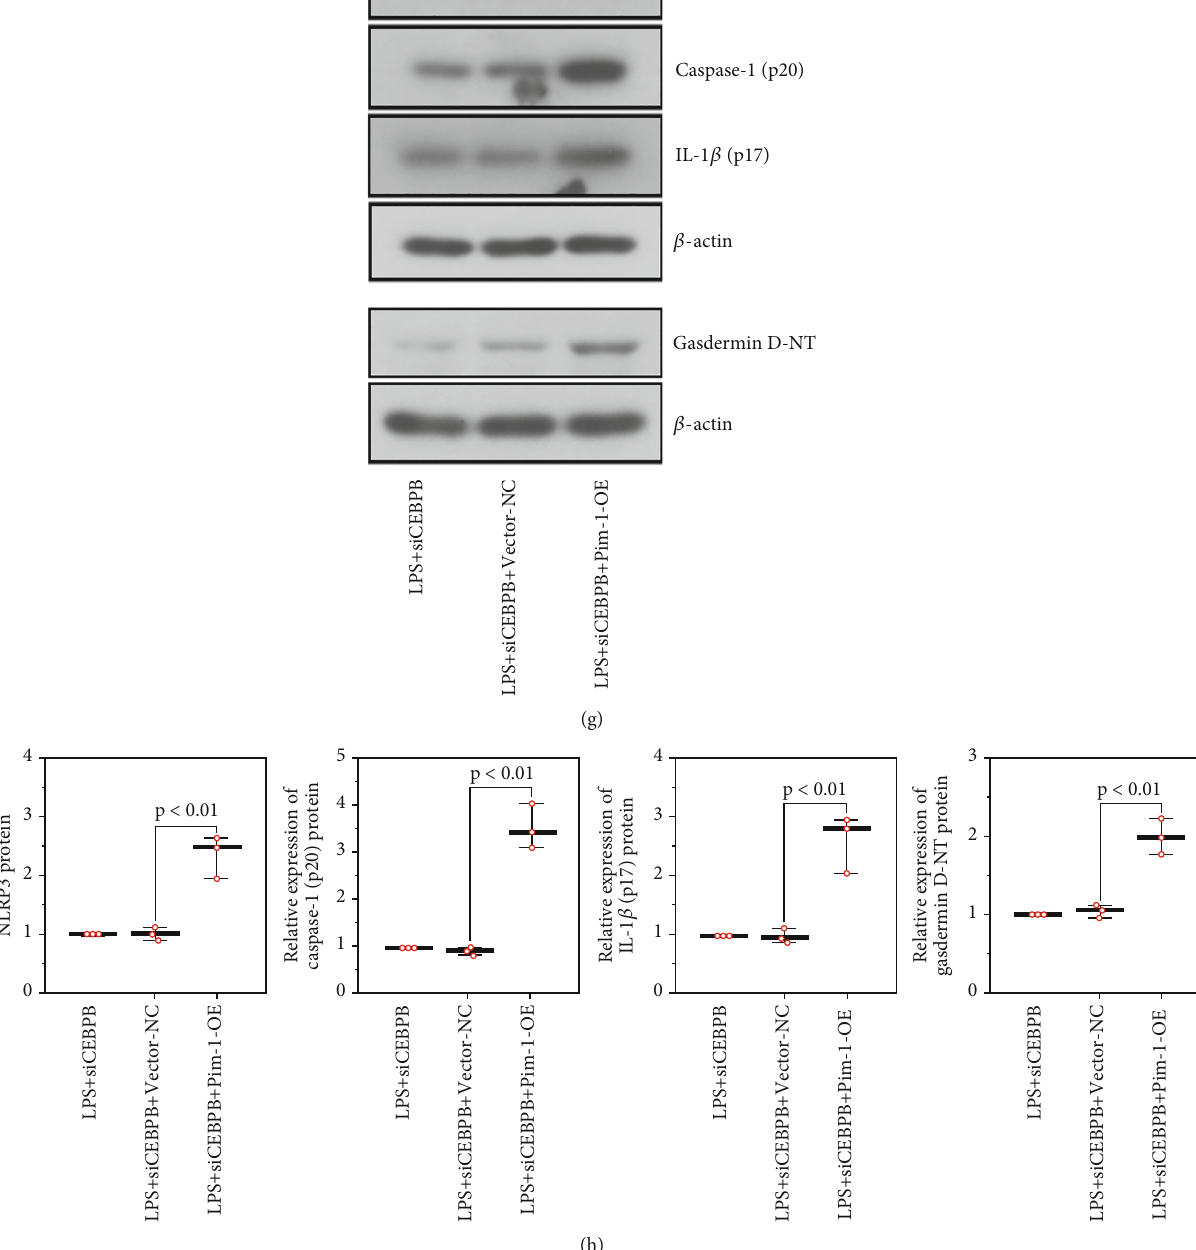
Figure 6: CEBPB regulated the activation of NLRP3 in fl ammasomes in glomerular podocytes via the regulation of Pim-1. The mRNA expression level of Pim-1 in CEBPB knockdown podocytes (a); the binding of Pim-1 promoter and CEBPB detected by chromatin immunoprecipitation (b) and dual-luciferase reporter assay (c); the transfect e ffi ciency of Pim-1 overexpression (d); the content of IL-1 β (e) and IL-6 (f) in the cell supernatant; Protein expression of key proteins in the in fl ammasome-related signaling pathway (g, h). (CEBPB, CCAAT/enhancer-binding protein β